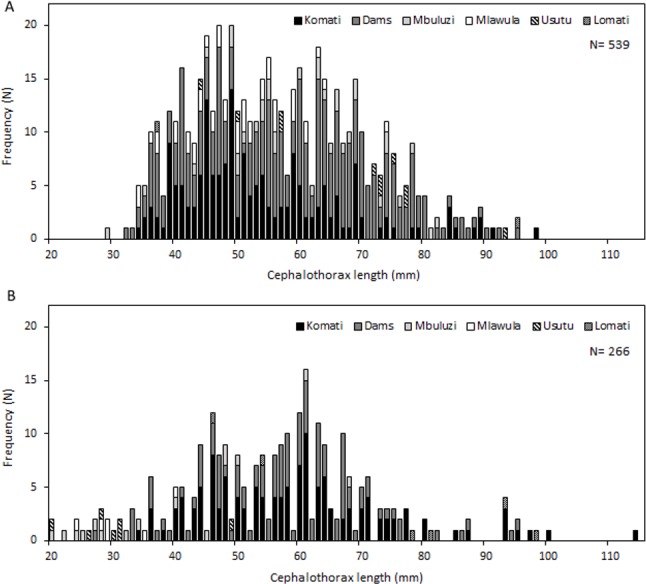
Length-frequency distributions of C. quadricarinatus in different locations of the Komati, Mbuluzi, Mlawula, Usutu and Lomati rivers and in irrigation dams.(A) Wet season and (B) dry season.